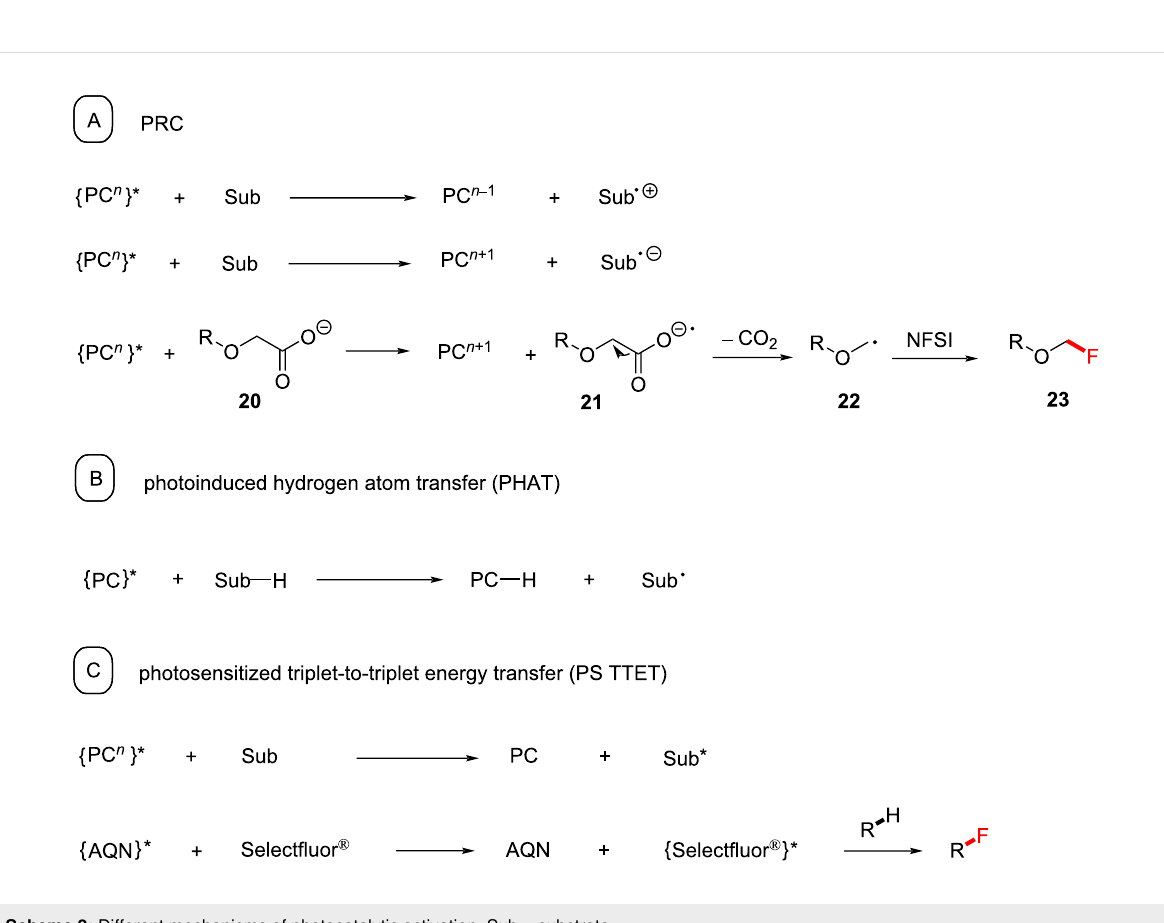
activate C–H bonds. For the purposes of this review, we label this reaction class involving redox processes as